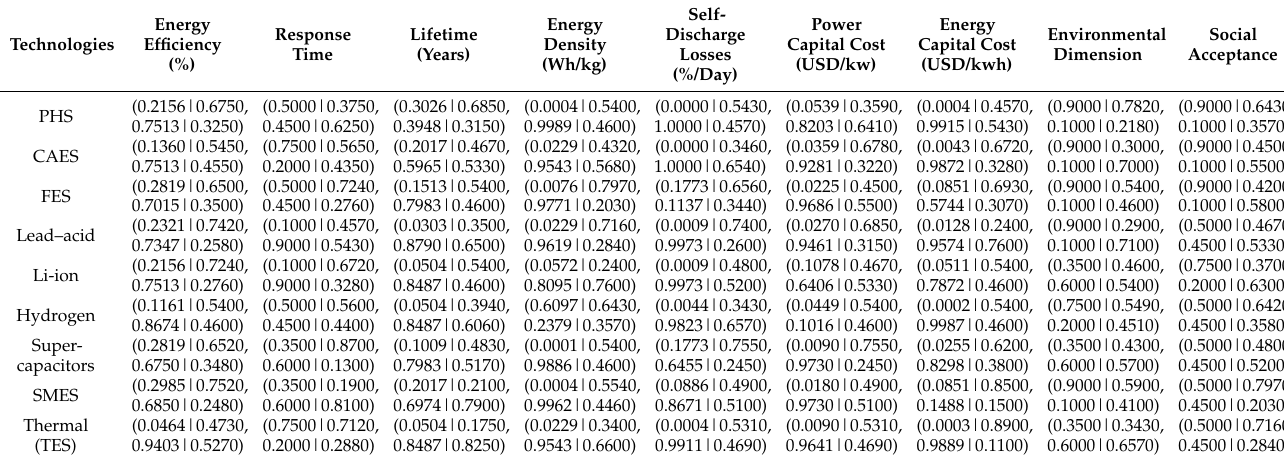
Table A8. Initial decision matric of Expert 5.